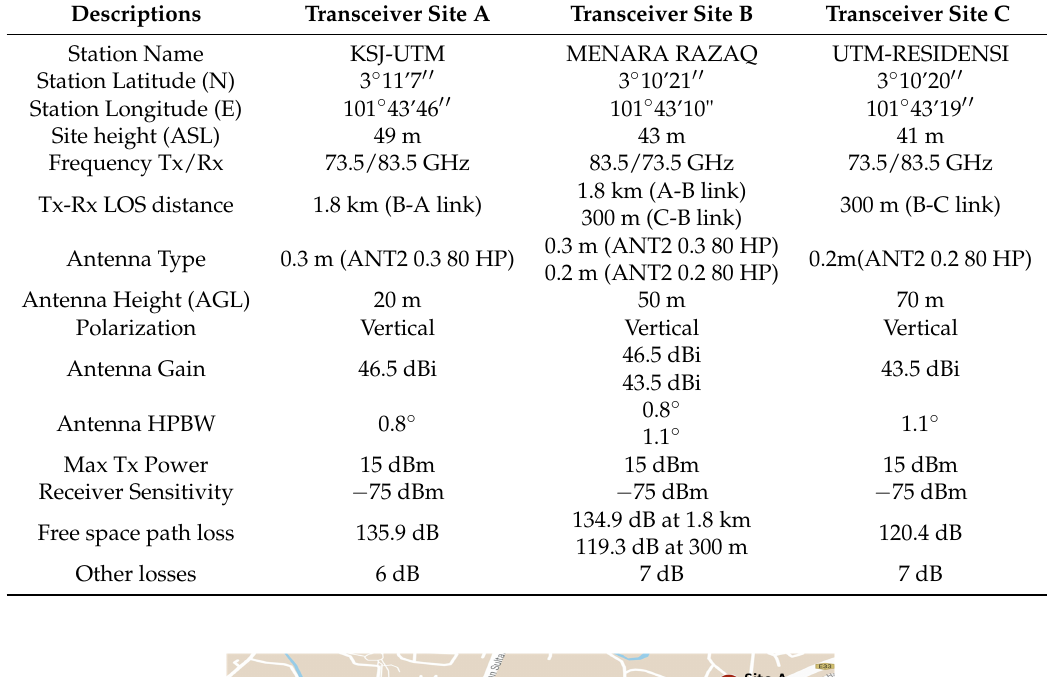
Table 1. Parameters of experimental E-band links.